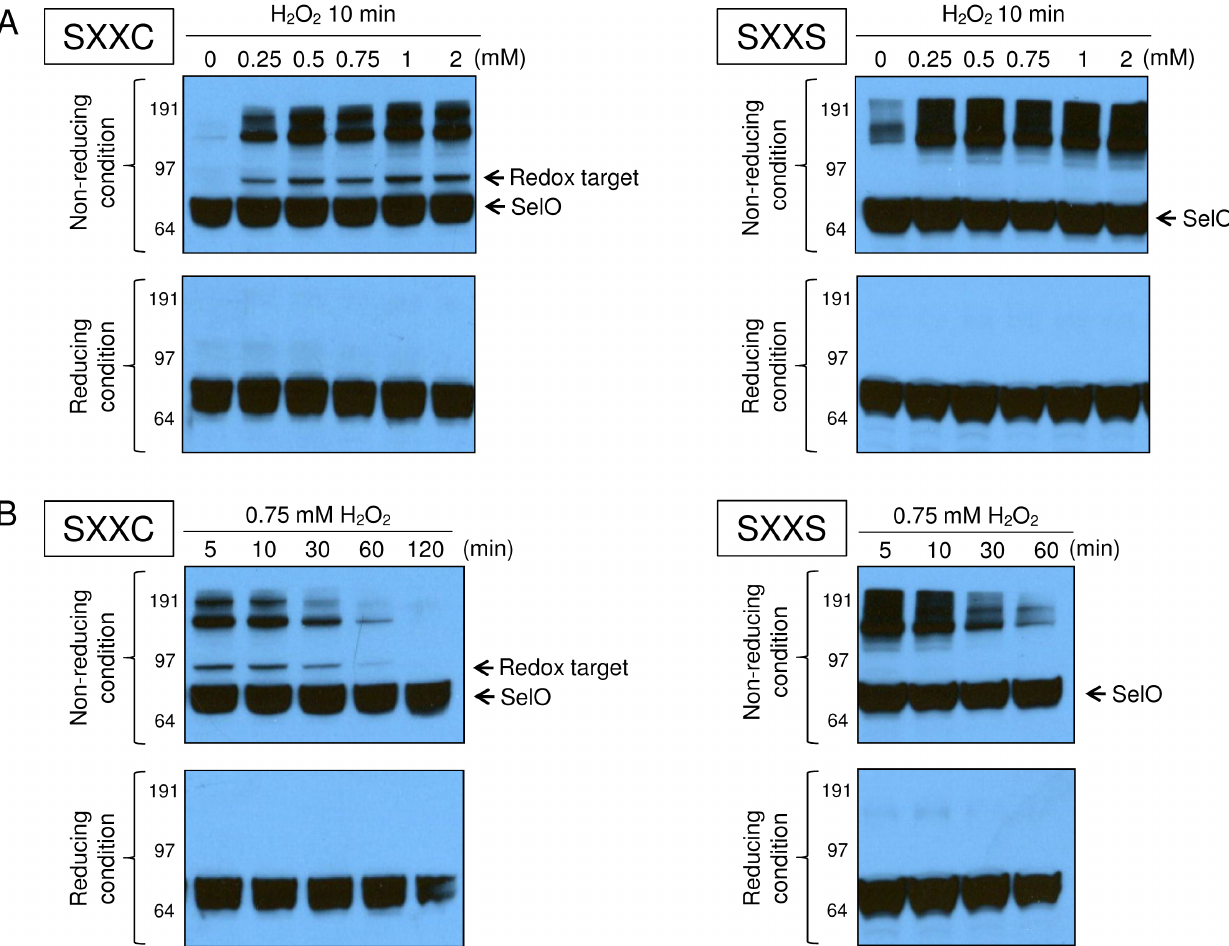
Figure 3. Effect of hydrogen peroxide on redox interactions involving SelO. (A) 0, 0.25, 0.5, 0.75, 1, or 2 mM hydrogen peroxide was added for 5 min to HEK293T cells expressing recombinant human SelO proteins containing either SXXC or SXXS. (B) 0.75 mM hydrogen peroxide was added to HEK293T cells expressing recombinant human SelO proteins containing either SXXC or SXXS motifs for 5, 10, 30, 60, or 120 min. Then, all cell lysates were subjected to Western blotting with anti-SelO antibodies under reducing or non-reducing